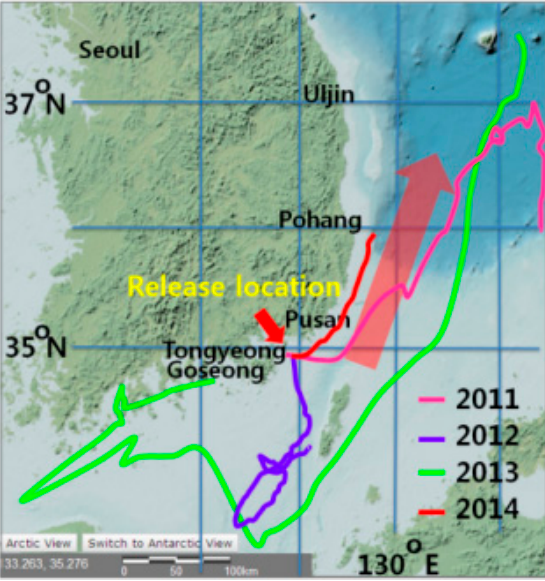
Figure 12. The migration route of pacific cod [20].